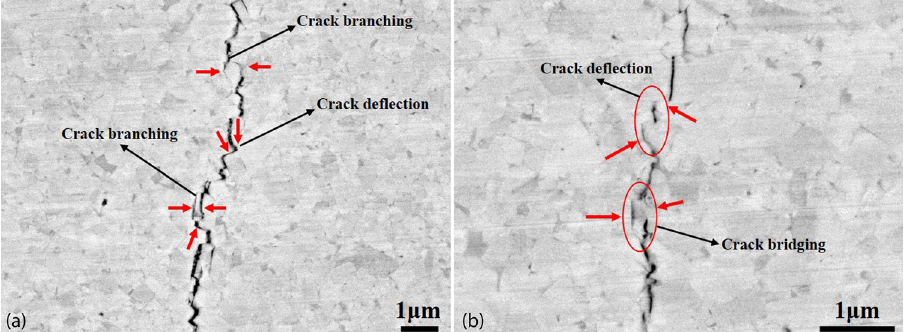
Figure 13: WCN - 6# specimen: ( a ) fracture toughness indentation map and ( b ) partial enlarged